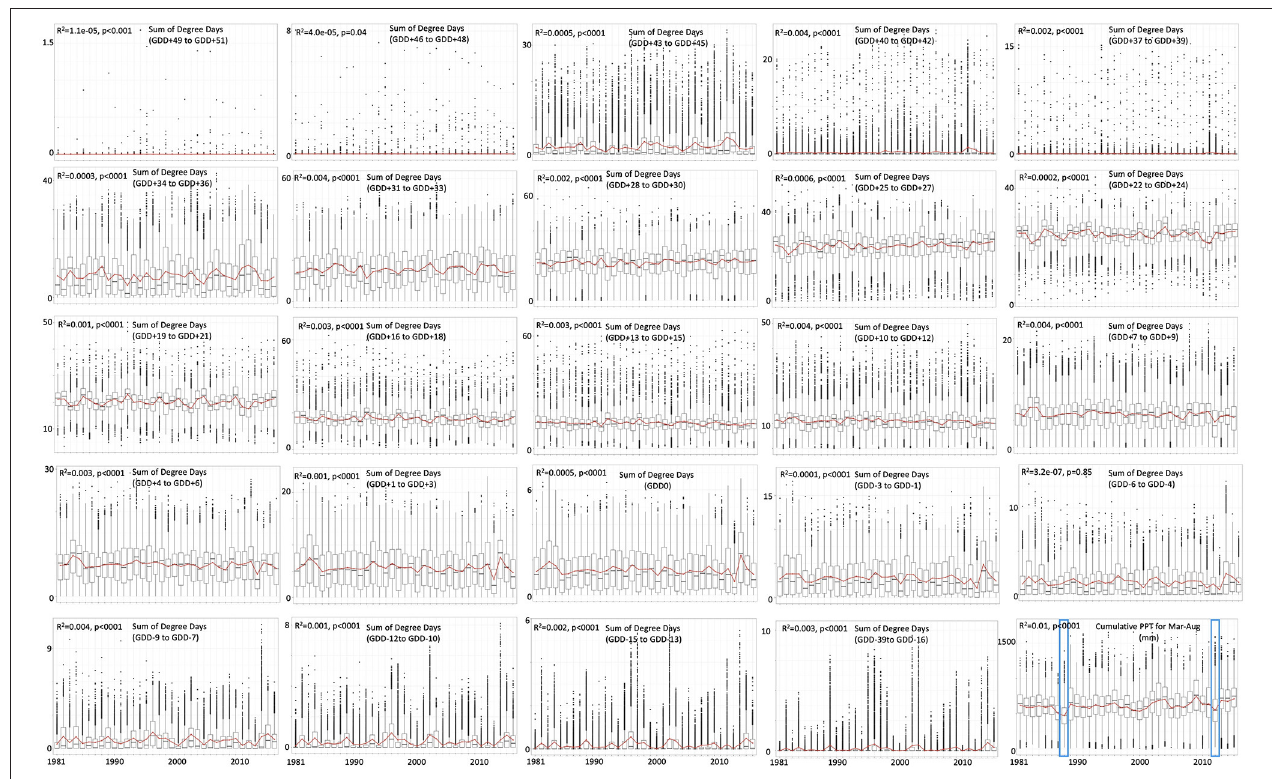
FIGURE 2 | Temporal trends of climate factors in the ACDC (Agro Climatic Data by County) dataset.